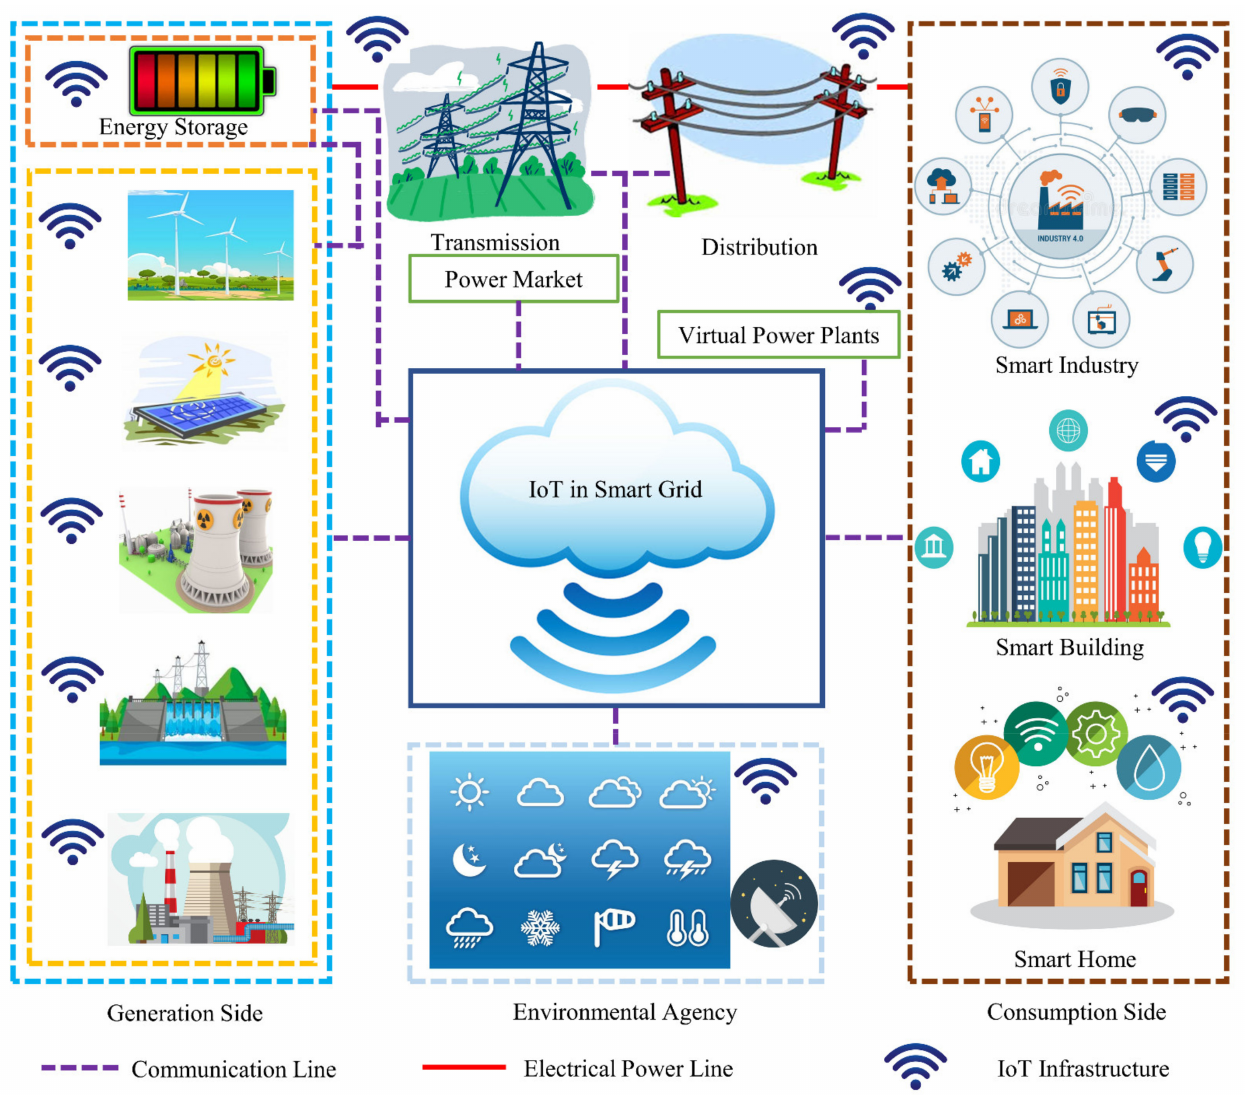
Figure 7. Prospective smart distribution network of